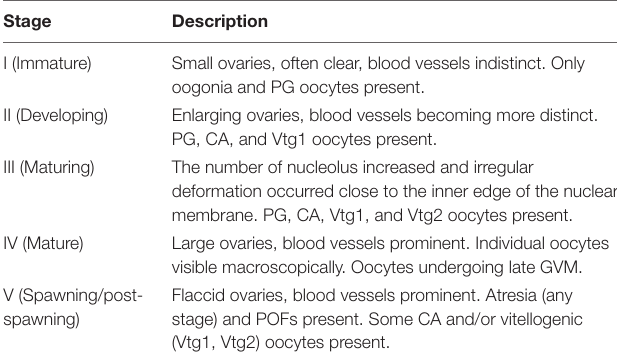
TABLE 2 | Histological descriptions of the stages in the reproductive cycle of female Megalobrama terminalis . Stage